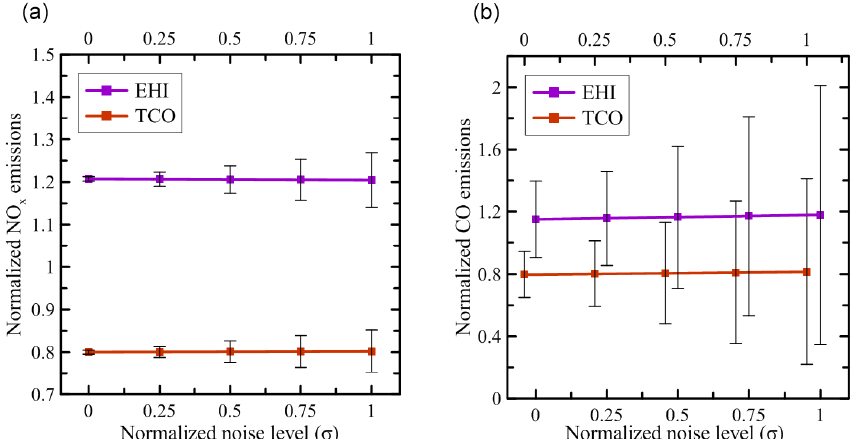
Figure 9. The NO x (a) and CO (b) emission estimates obtained similarly to the estimates shown in Fig. 8 but separately for the two source categories (EHI and TOC) in the OSSEs, where the “true” emissions in the EHI and TCO were specified by scaling the corresponding bottom-up emissions (employed in the base case model run) with the factors of 1.2 and 0.8. Note that the estimates for the EHI and TCO categories are depicted by using the abscissa axes at the bottom and at the top of the plots,